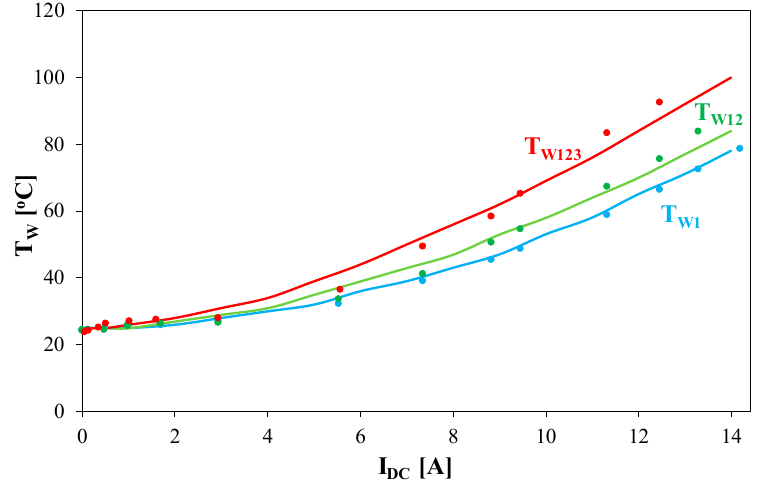
Figure 16. Dependence of the inductor winding temperature on the direct current I DC flowing through one T W1 , two T W12 , or three T W123 windings connected in series.